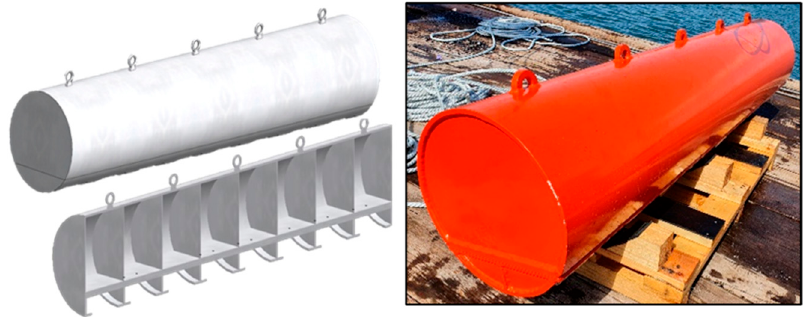
Figure 5. Mock-up cylindrical model. The interior of the mock-up was filled with air to resemble the acoustic properties of the underwater object to be detected in a real situation.